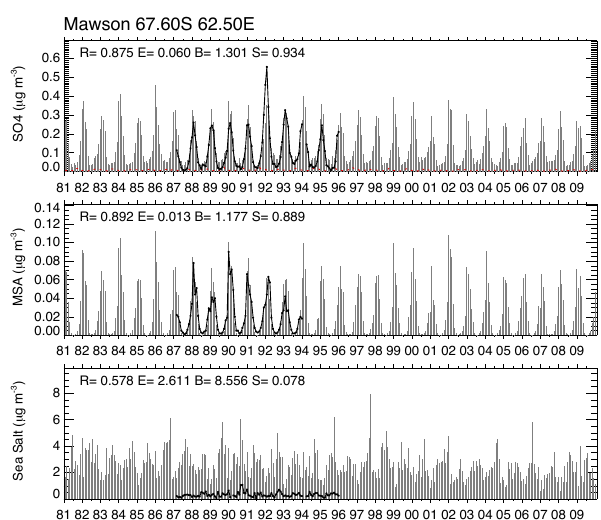
Fig. 10c. Same as Fig. 10b but for sulfate, MSA, and sea salt at Mawson Station on the Antarctic coast and without the ratio of an- nual mean to data average (data record is too short for deriving the